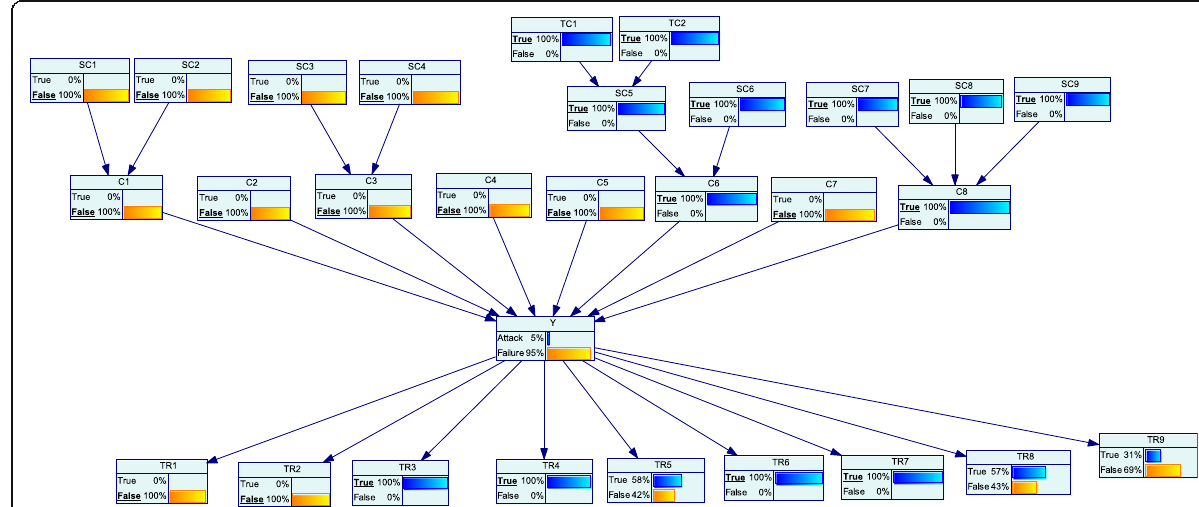
Fig. 8 Constructed BN Model – First Illustrative